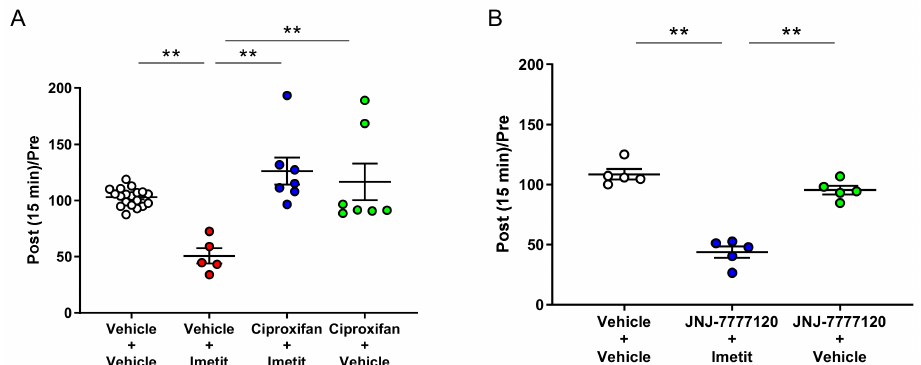
Figure 6. Ciproxifan (an H 3 R antagonist ( A )), but not JNJ-7777120 (an H 4 R antagonist ( B )), signif- icantly inhibited the suppressive effect of imetit on neuronal firing of the spinal dorsal horn. The post and pre-administration ratios are displayed. Data are presented as the mean ± S.E.M. ** p < 0.01 analyzed using Tukey’s multiple comparison test (n =